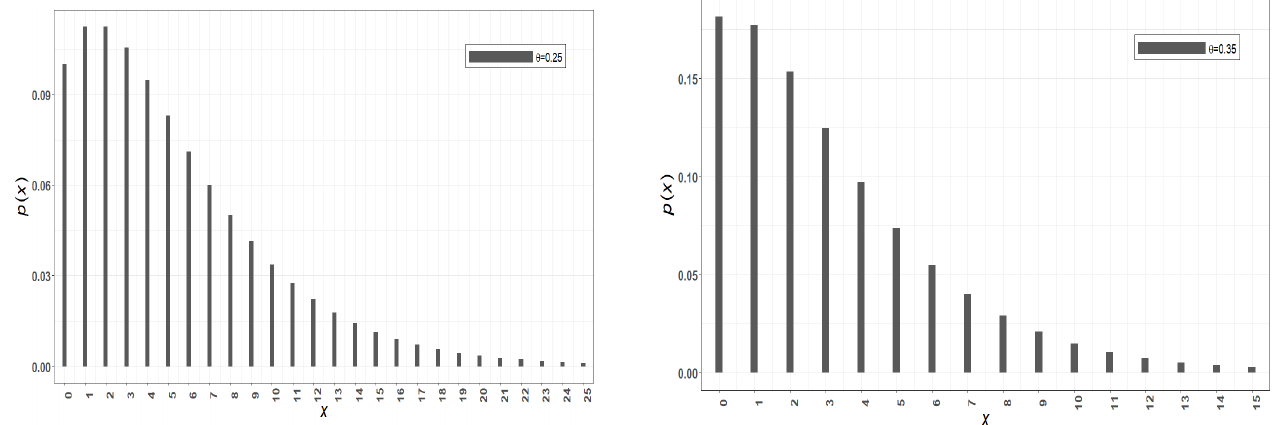
Figure 1. Probability mass function (PMF) plots of the natural discrete Lindley (NDL) distribution.